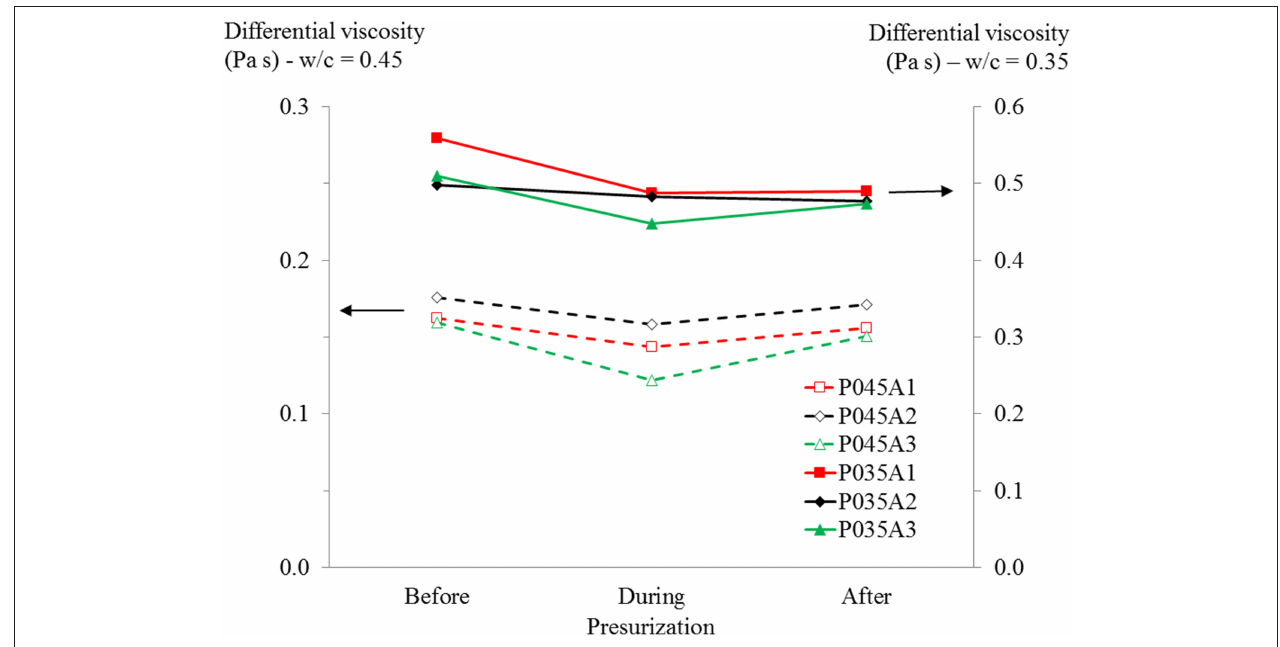
FIGURE 8 | Differential viscosity at 50 s − 1 . Mixtures with w/c = 0.45 are plotted on the left axis, those with w/c = 0.35 on the right axis.